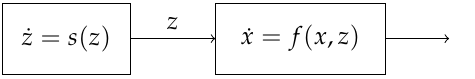
Figure 1. Cascade interconnected